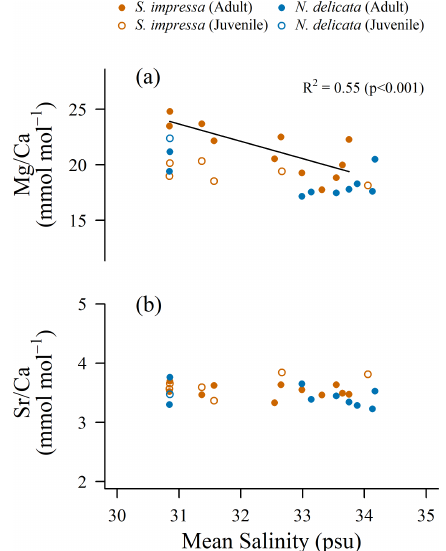
Figure 4. Mg / Ca and Sr / Ca correlation to salinity for S. impressa ( η = 7) and N. delicata ( η = 3) for salinity recorded in April consid- ering mean